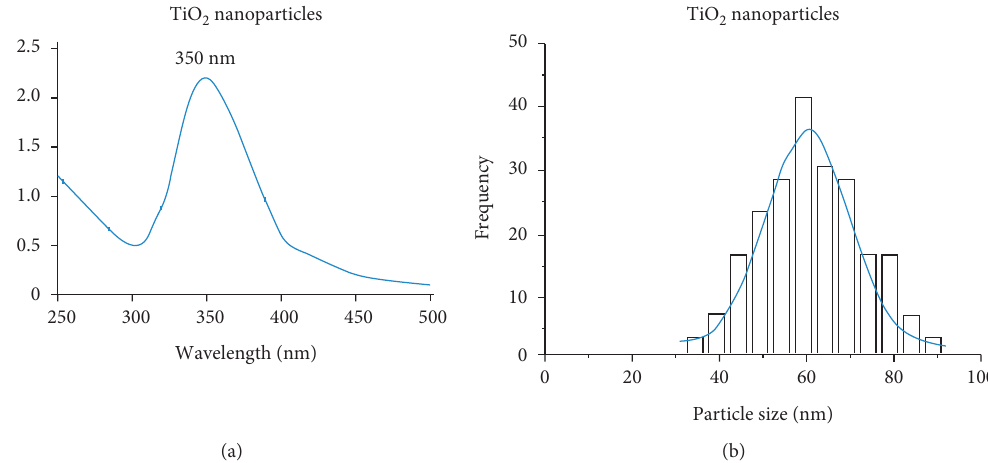
Figure 2: (a) UV-Vis spectrum of TiO2 nanoparticles and (b) average particle size using the particle size